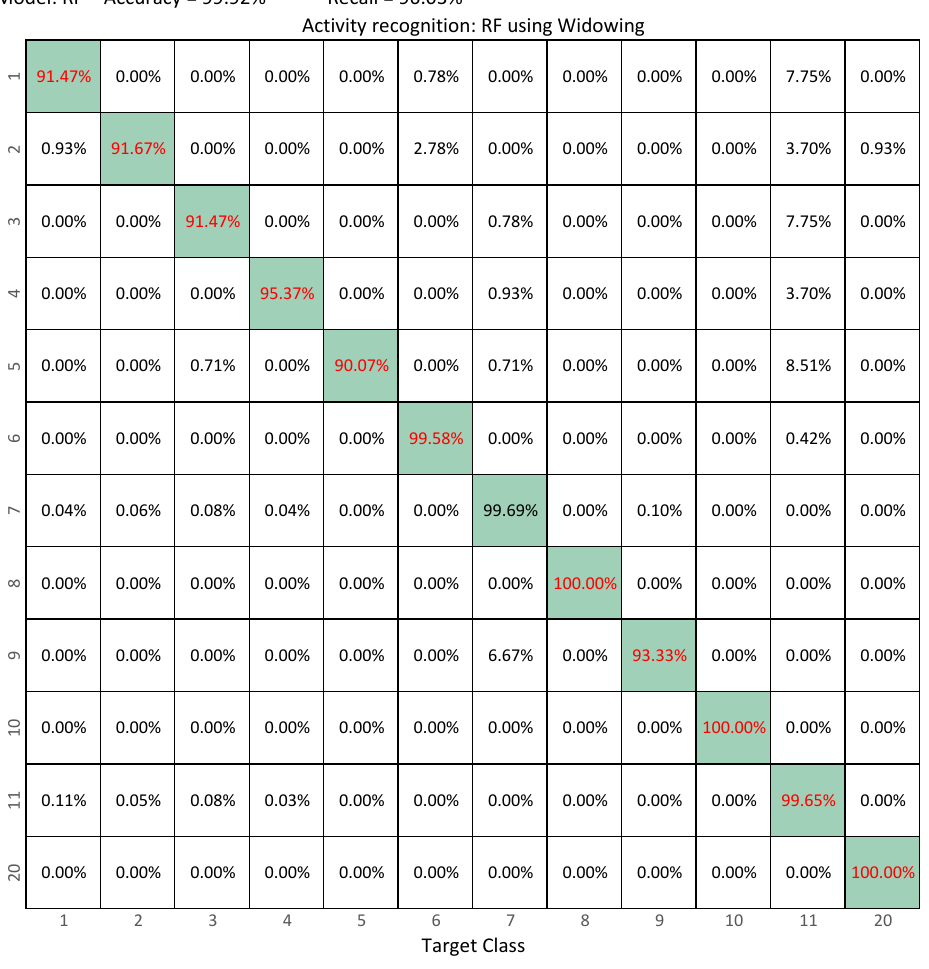
Figure 7. Confusion matrices in activity recognition: Windowing+RF. Best results are shown in red. Table 6. Other methods using skeletons for fall detection and activity recognition. Please consider the following meaning (cid:88) —Yes,